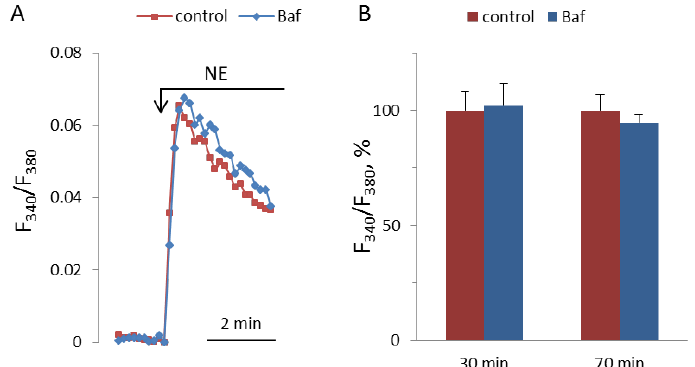
Figure 12. Kinetics of [Ca 2 + ] i rises in response to 100 µ M NA in SMCs after 30 min preincubation with or without 0.5 µ M bafilomycin A1 ( A ), and NA-induced [Ca 2 + ] i increments after 30 and 70 min preincubation with or without bafilomycin A1 ( B ). The rise of [Ca 2 + ] i in the absence of bafilomycin A1 is taken as 100%. Each value in panel B is a mean + SEM of six independent